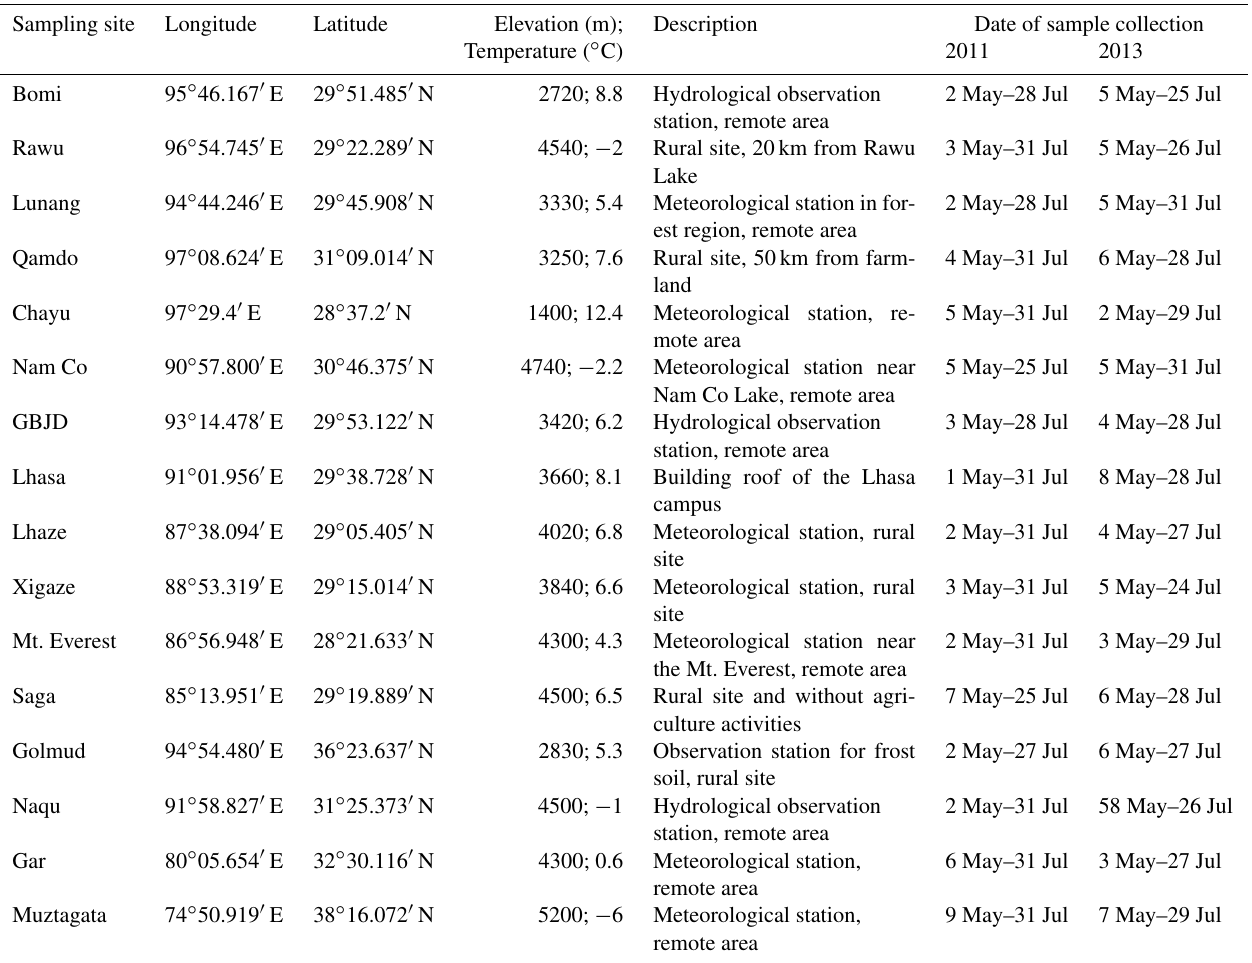
Table 1. Description of the sampling programme. Sampling